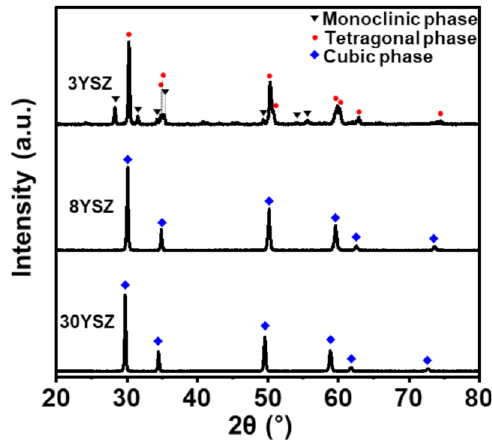
Figure 6. XRD patterns of the sintered YSZ bodies: 3YSZ ( top ), 8YSZ ( middle ), and 30YSZ ( bottom